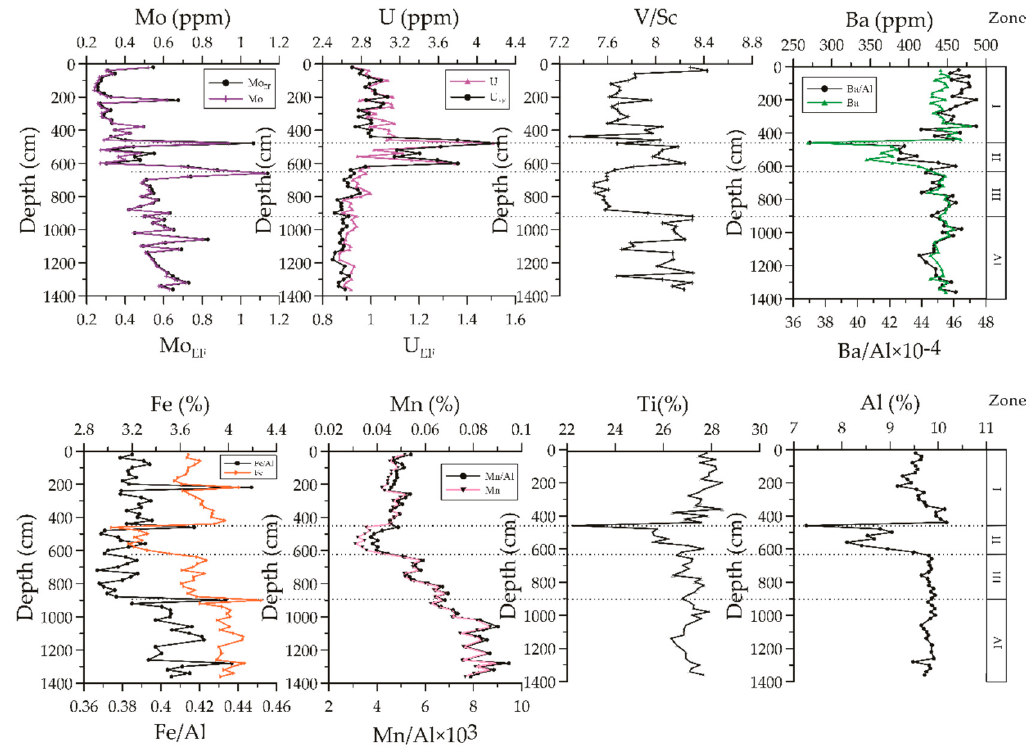
Figure 5. Depth profiles of Fe, Mn, Ti, Al, Mo, U, Ba, and ratios of Fe/Al, Mn/Al, Mo EF , U EF , Mn/Al, V/Sc, and Ba/Al in sediments of site 973-4.